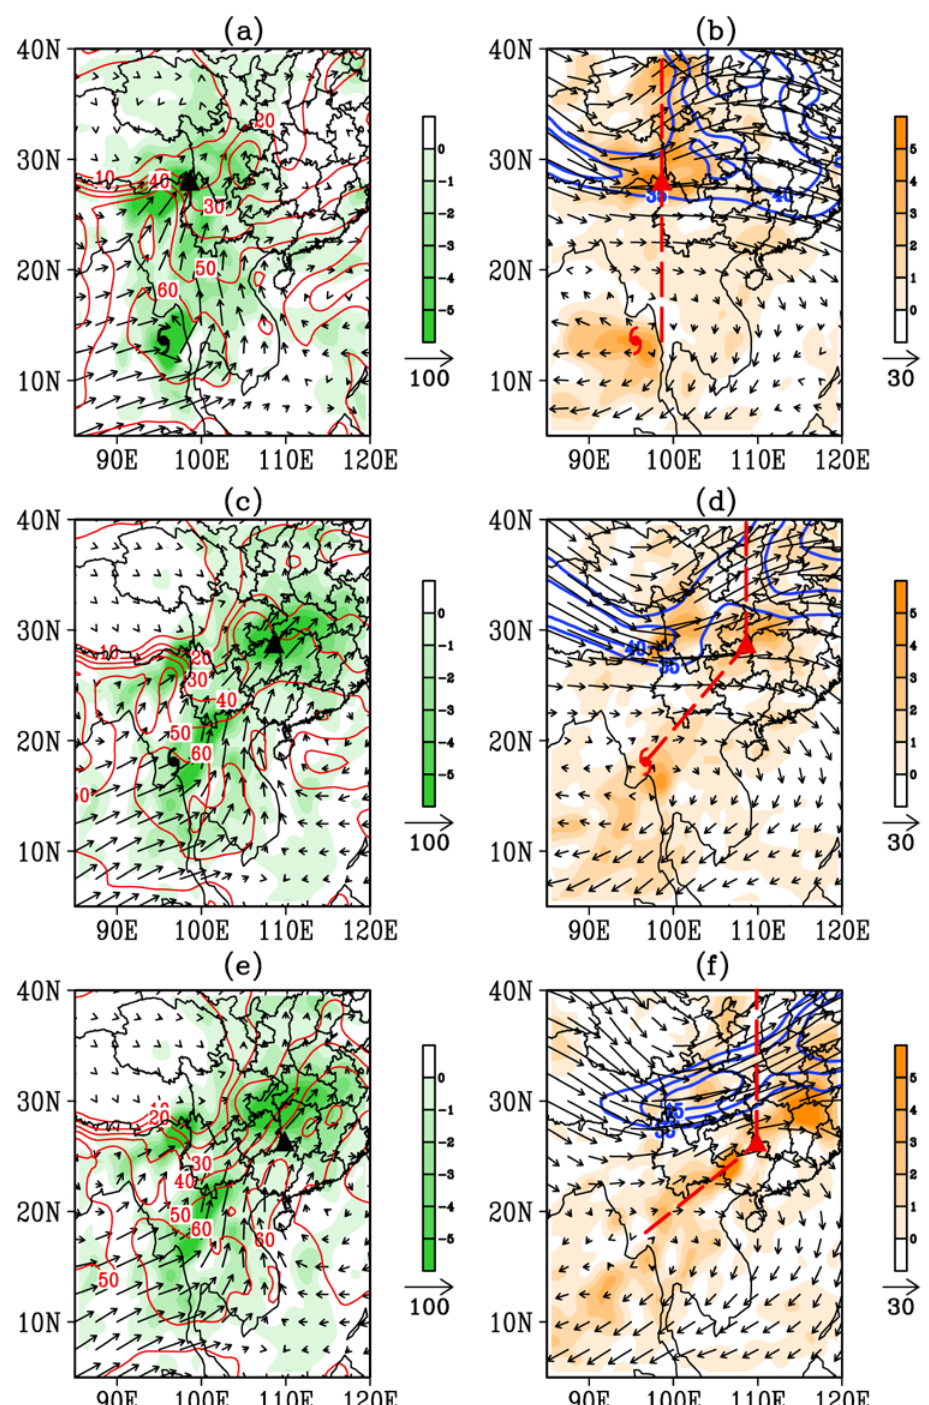
), divergence of the 279 3 −1 −1 ) and total-column precipitable 280 10 g ∙ m ∙ s −2 −2 −1 10 g ∙ m ∙ s ) and divergence of horizontal wind (shaded, units: ) at 200 hPa 282 −1 −5 −1 m ∙ s 10 s are indicated by purple solid lines in ( b ), ( d ) and ( f ). 285 −1 m ∙ s